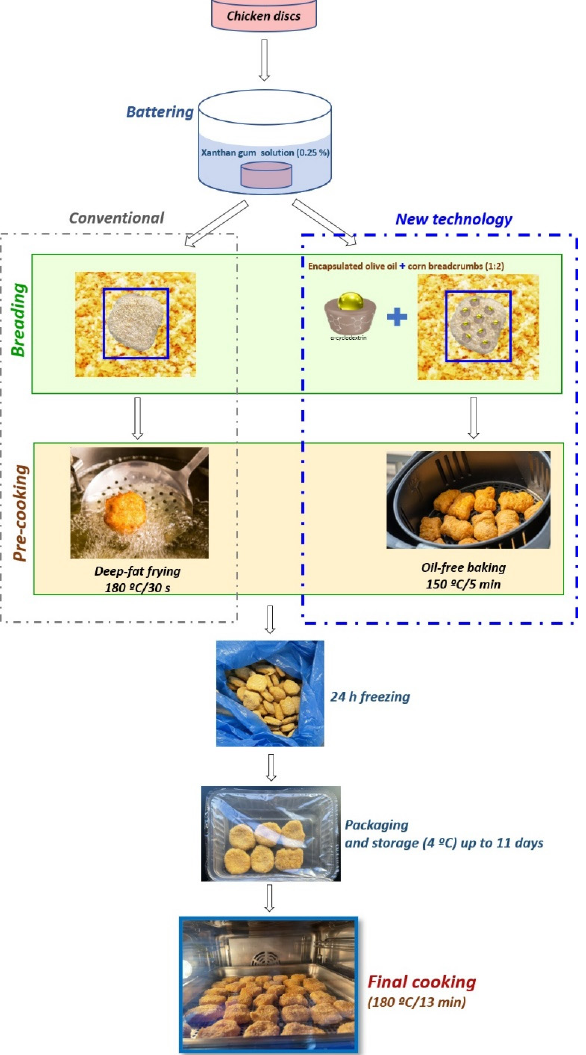
Figure 1. Flowchart production of chicken nuggets with the conventional method and the proposed new